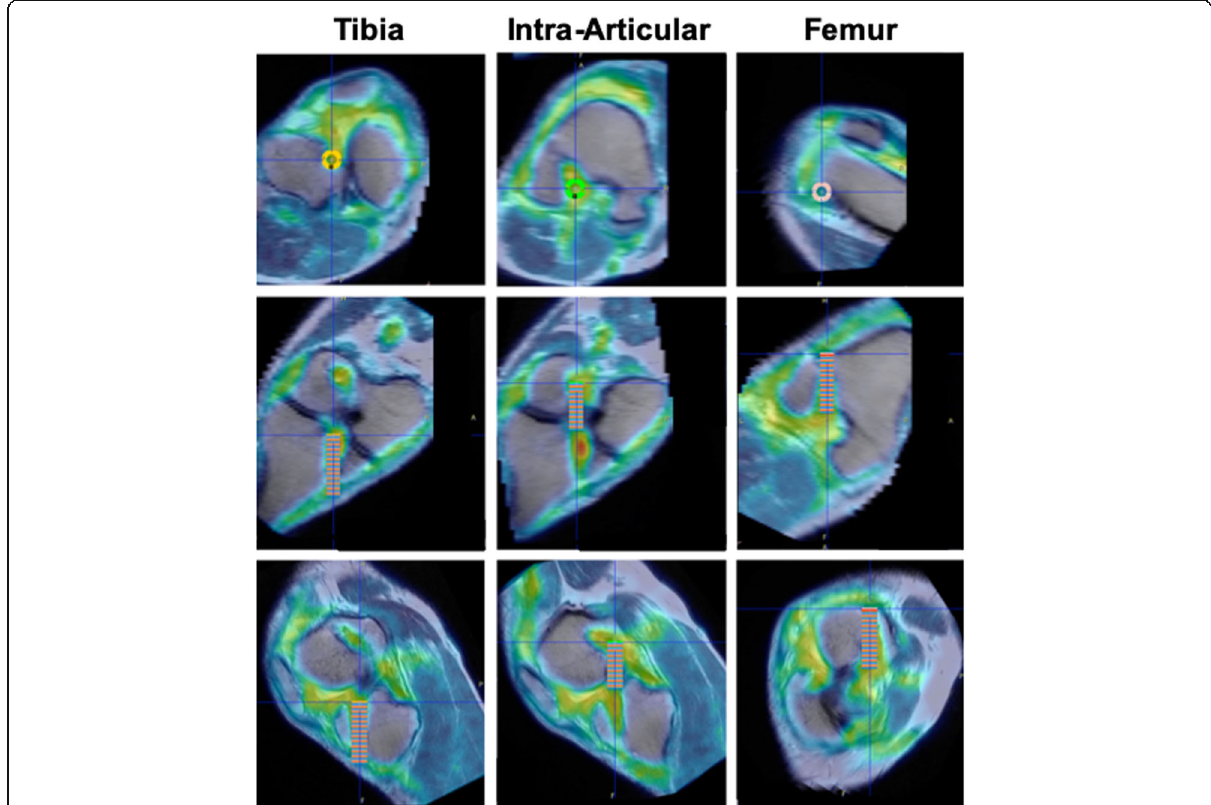
Fig. 2 Realignment of PET/MRI images for quantitative analysis. Images showing the re-sliced PET/MRI images for the tibial tunnel, intra-articular graft, and femoral tunnel. The images were aligned so that the tunnels and graft were perpendicular to the imaging plane on axial (top), sagittal (middle), and coronal (bottom) views. Multiple circular regions of interest matching the tunnel diameters were then positioned on the images (colored overlay) to quantify regional 18 F-FDG uptake